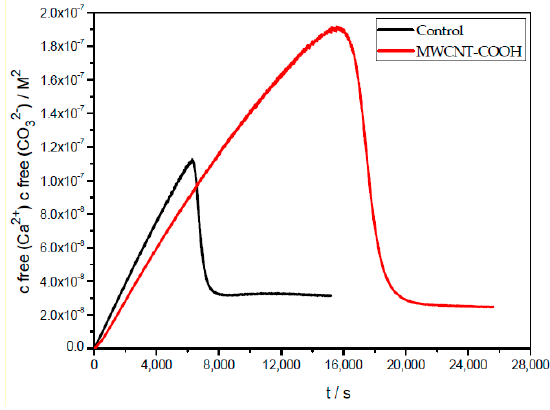
Figure 7. Time development of CaCO 3 solubility products using 2.5 mg/L MWCNT-COOH at pH 9.0: control ( black line ) and 2.5 mg/L ( red line